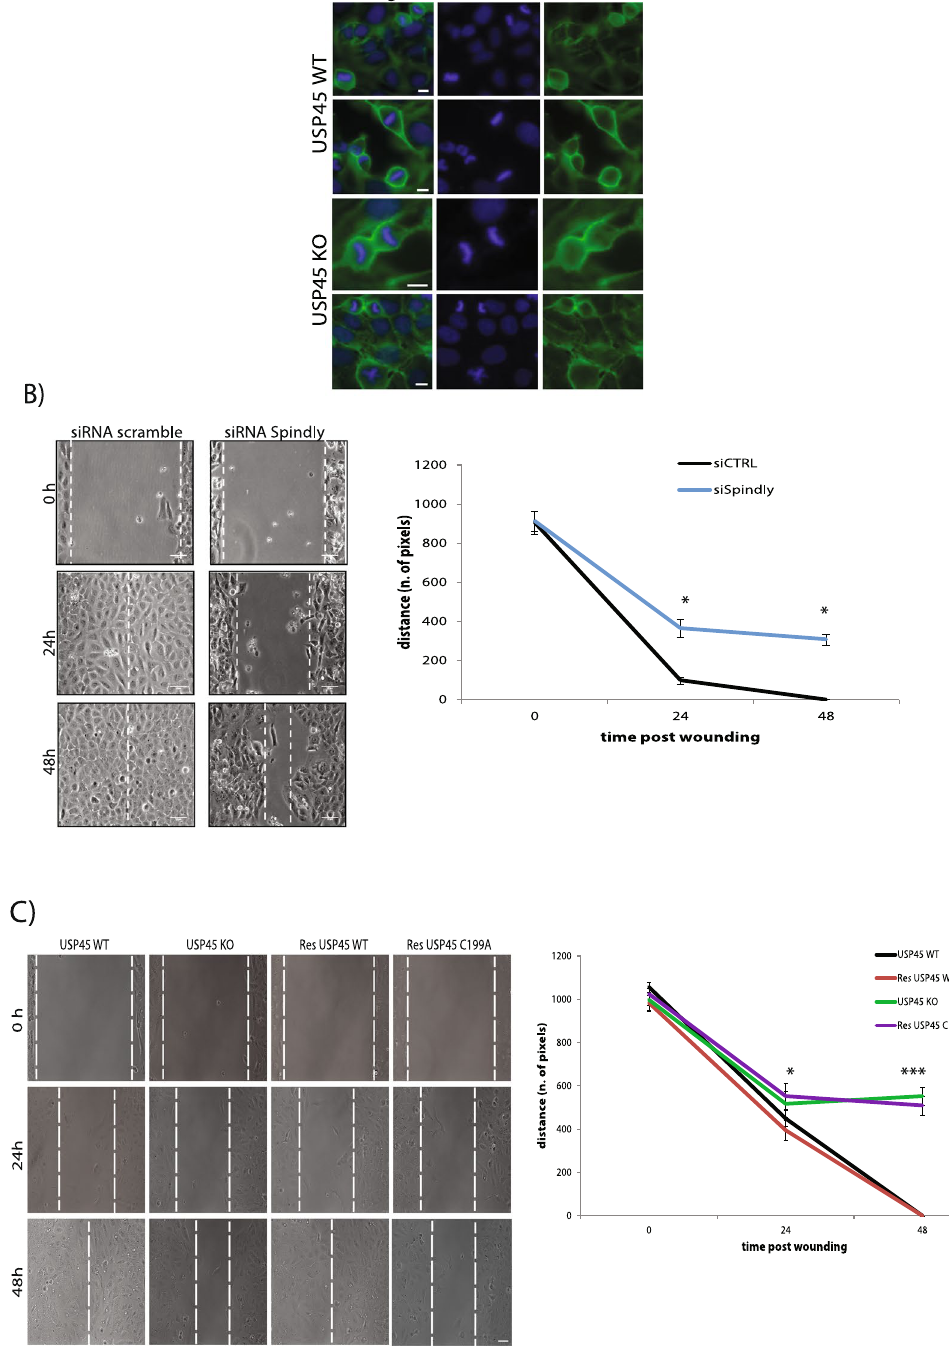
Figure 5. Silencing of USP45 or Spindly leads to defects in cell migration. ( A ) U2OS cell lines either expressing USP45 WT or KO were analysed for cytokinesis rate. The figure shows that the lack of USP45 does not affect the cytokinesis process and cells division as show the DAPI staining. Staining as follow: Actin (Phalloidin, green), nuclei (DAPI, blue). 60X magnification. Scale bars: 5 μ m. ( B ) Images from time-lapse analysis of wound healing assay of U2OS cells treated either with siRNA control (scramble) or siRNA for Spindly (siRNA Spindly). Dotted white lines indicate the edge of the wound. Three independent experiments were performed and data in the graph represent mean ± s.d. Scale bars: 10 μ m. ( A , B ) All experiments were performed at least three times and a representative example is shown. ( C ) USP45 WT or KO U2OS cells. Transient transfection of USP45 KO U2OS cells with USP45 WT construct rescued the delay defects; while instead transient transfection of KO U2OS cells with catalytic inactive USP45 (C199A) construct maintain the defect. Dotted white lines indicate the edge of the wound. Three independent experiments were performed and data in the graph represent mean ± s.d. Student t-test was used to determine the statistical significance. Scale bars: 10 μ